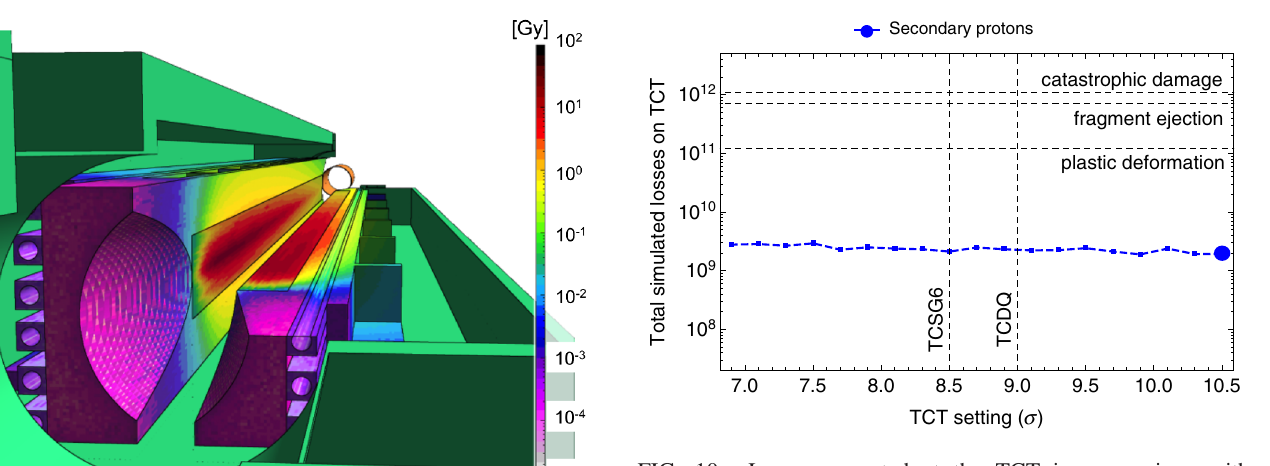
FIG. 10. Losses expected at the TCT in comparison with estimates of damage of the tungsten jaw for Case 1. The losses are estimated assuming a bunch population of 1 . 3 × 10 11 p = b.